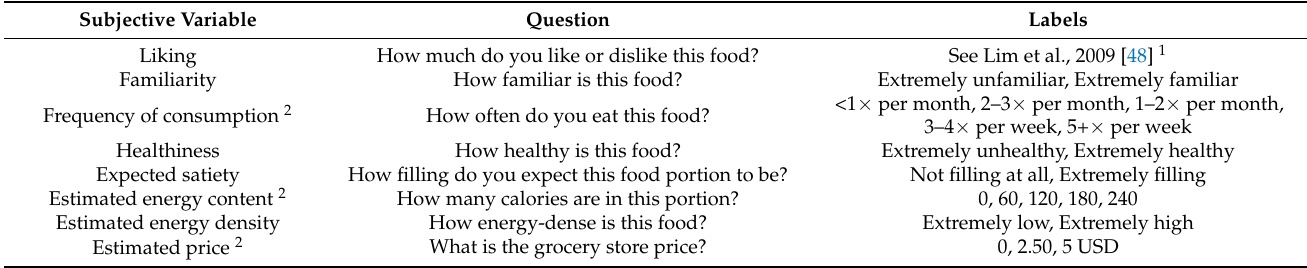
Table 2. Questions and labels for the food subjective rating